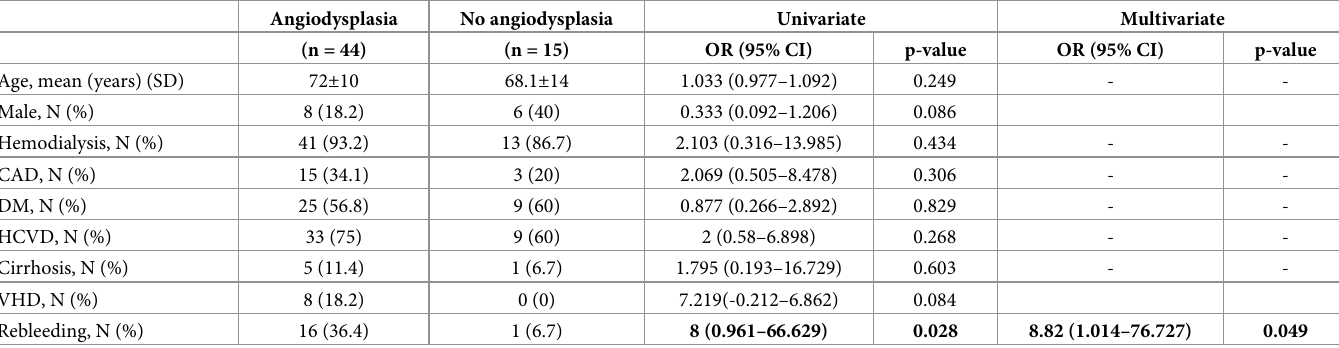
Table 5. Comparison of the clinical characteristics of patients with and without angiodysplasia. Angiodysplasia No angiodysplasia